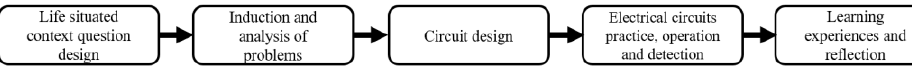
Figure 8. Process flow of situational performance evaluation.